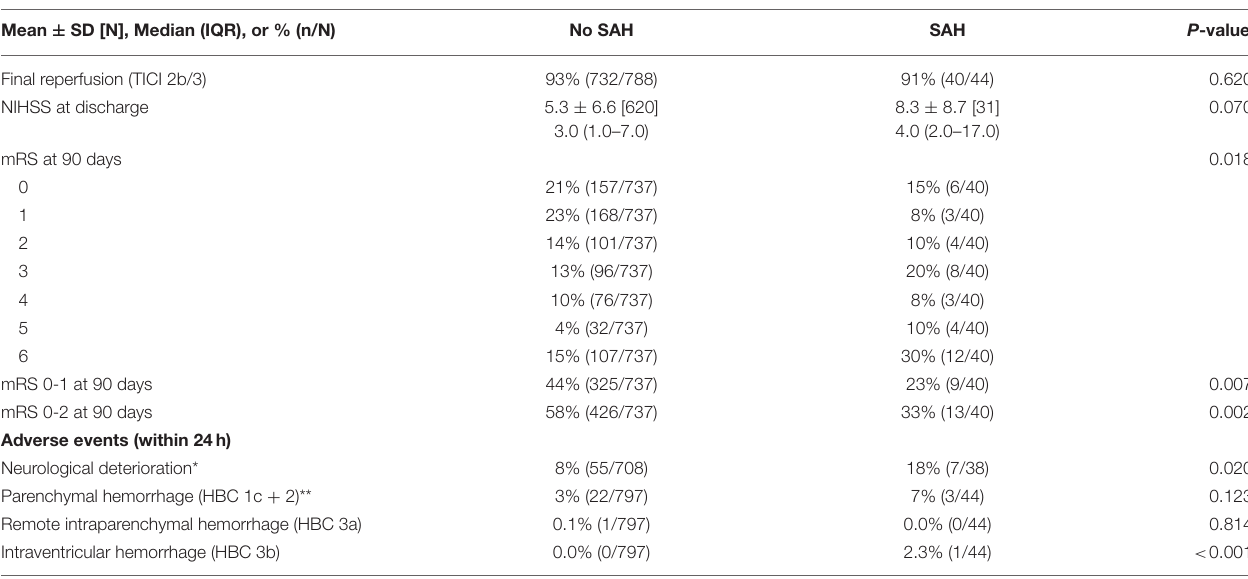
TABLE 4 | Procedural and functional outcomes in